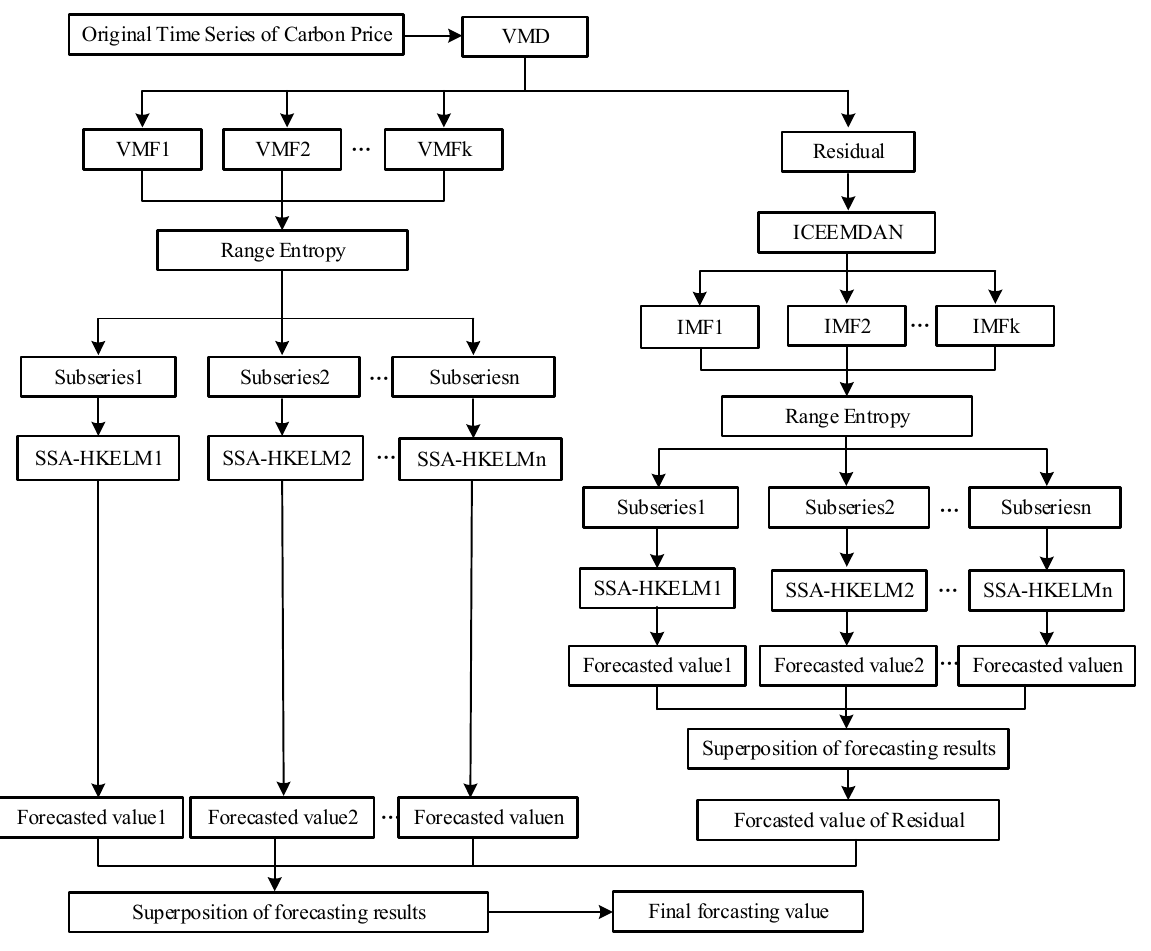
Figure 1. Flowchart of the proposed model for forecasting the price of carbon, VMD ‐ ICEEMDAN ‐ RE ‐ SSA ‐ HKELM.